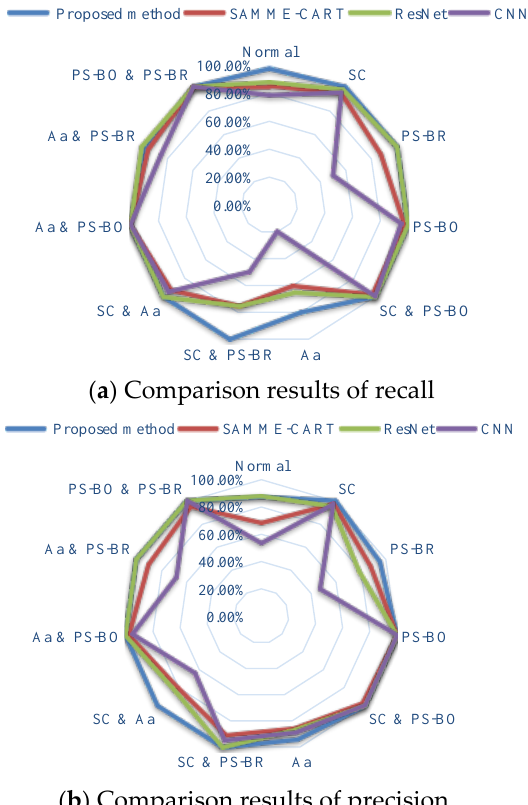
Figure 9. Comparison results of each fault category by four methods. ( a ) Comparison results of recall; ( b ) Comparison results of precision.